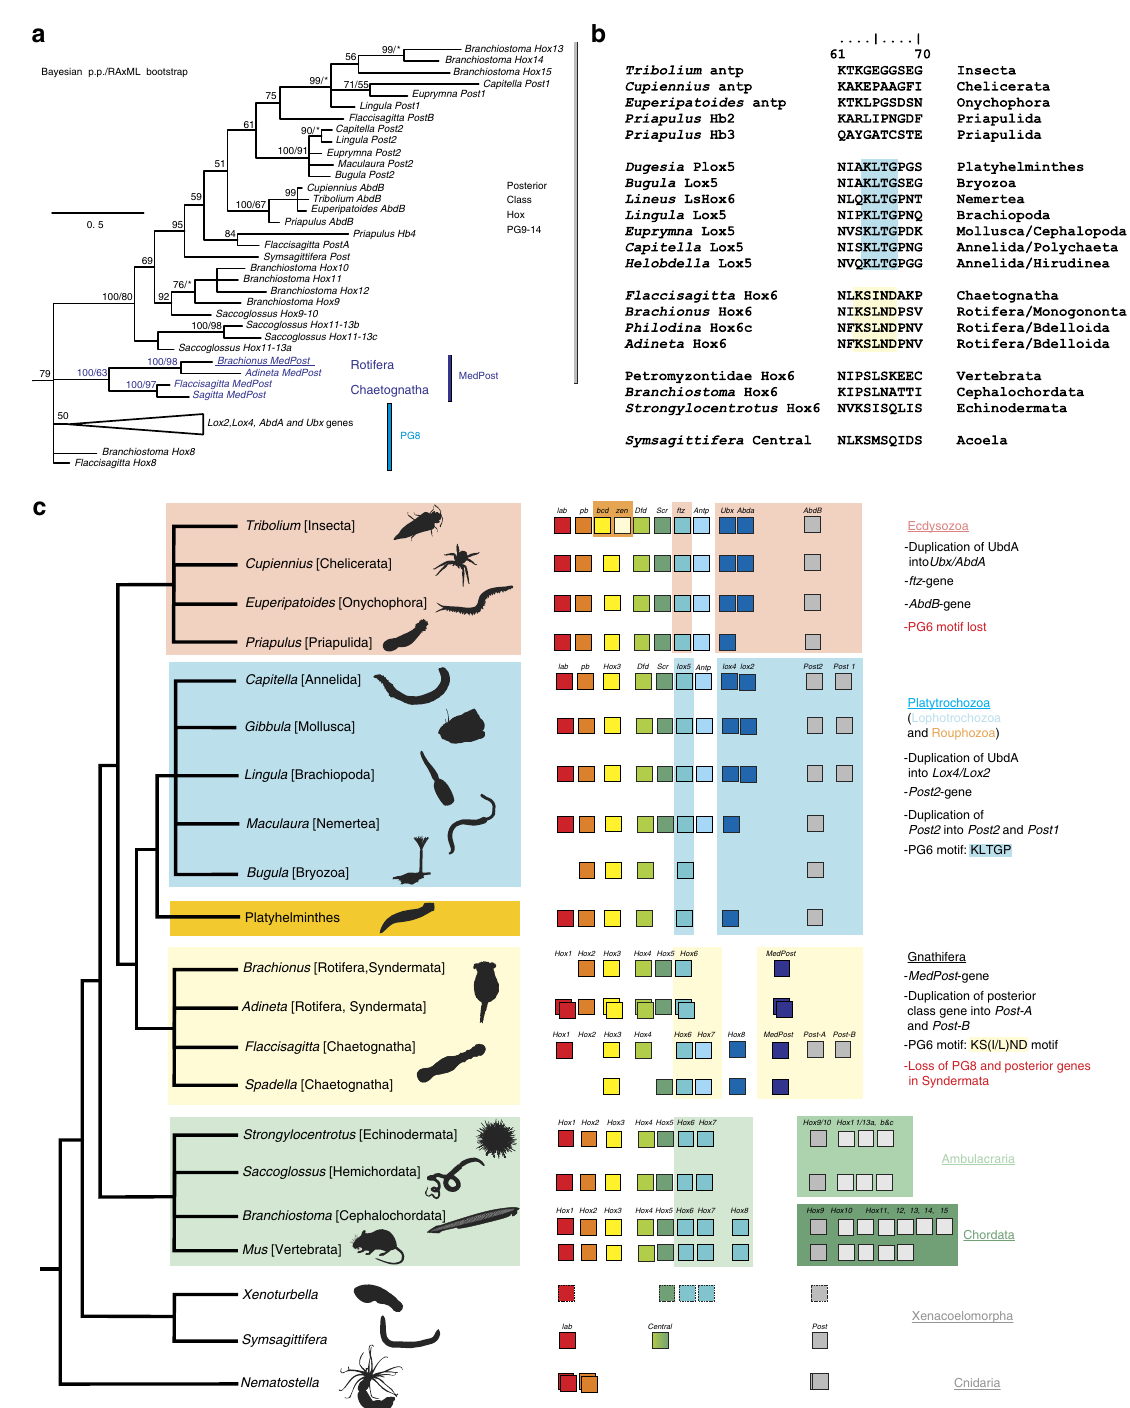
Fig. 1 Hox gene data places rotifers and chaetognaths in Gnathifera within Spiralia. a Phylogenetic tree depicting the relationship of MedPost genes to PG8 and posterior class Hox genes. Tree topology is from Bayesian analysis. Bayesian posterior probabilities based on 400,000 trees from 40,000,000 generations and ML support values from 1000 iterations are shown above branches. Single values represent Bayesian posterior probabilities only. Asterisks denote ML support below 50%. b Alignment of ten amino acids of the carboxy fl anking region to the homeodomain of PG6 genes. Sequences highlighted with yellow contain the new signature found in rotifers and chaetognaths. Blue highlighting marks the lox5 -parapeptide of lophotrochozoan genes. Neither is found in Ecdysozoa, Ambulacraria, Chordata, or Xenacoelomorpha. c Summary of representative characteristics of the Hox cluster within different metazoan taxa. The tree to the left represents bilaterian phylogeny with Cnidaria as an outgroup. Boxes in the middle depict Hox gene contingents (color coded according to the assignment of the Hox genes to the different paralogous groups) isolated from representative species. The right hand column summarizes characteristic Hox gene evolution and duplication events along with presence of special Hox signatures resulting in Hox genes characterizing the respective